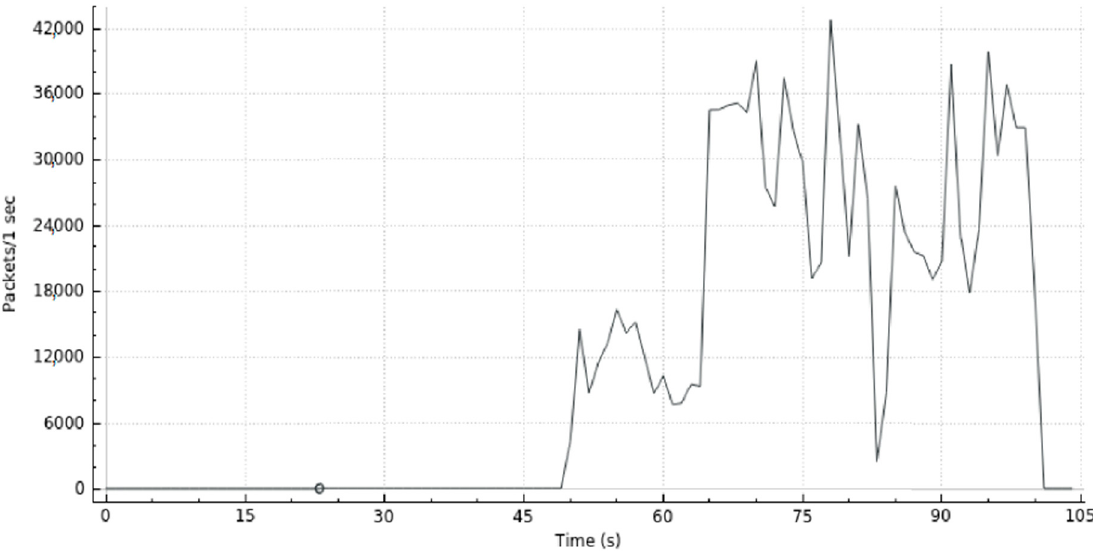
Figure 8. Network Traffic injected by a DDoS Attack when our Defense System is Off.